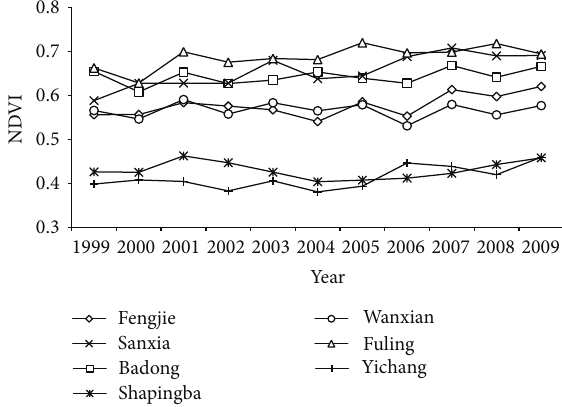
Figure 6: The slope of vegetation activity trend in each weather station during the period.